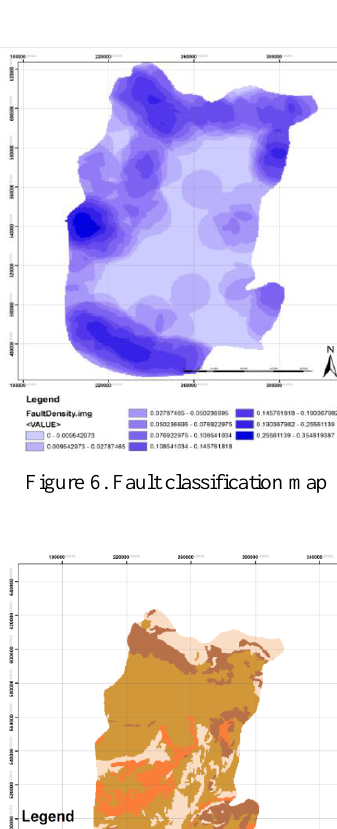
Figure 5. land cover classification map